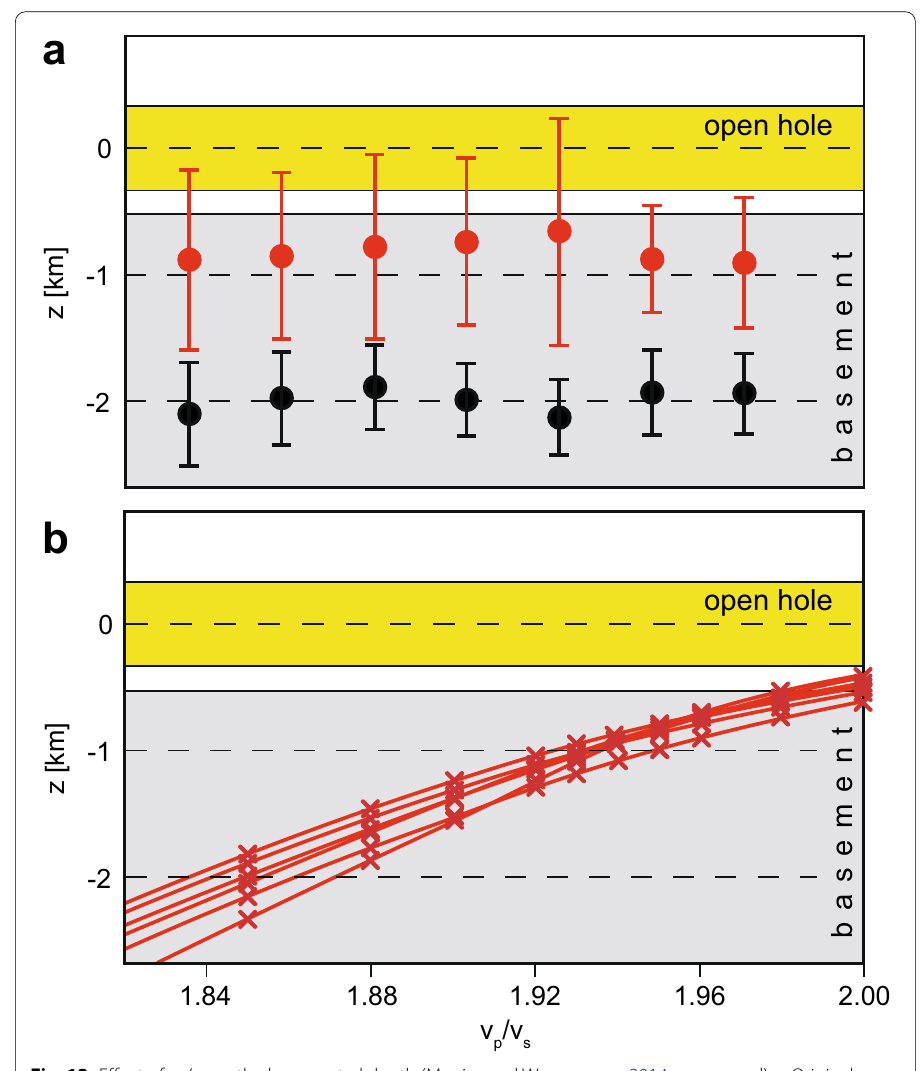
Fig. 13 Effect of v p /v s on the hypocentral depth (Megies and Wassermann 2014, rearranged). a Original hypocenter depths of seven events at Unterhaching based on a v p /v s ratio of 1.65 (black) and hypocenter depths based on a half-space model (red) with a ratio of 1.94 that was derived from rms residual minimization. b Individual variation of hypocenter depths of the seven events shown for a half-space model. As the v p /v s ratio approaches 2, hypocenter depths move closer to the top of the crystalline basement. Reprinted from Geothermics, 52, Megies T, Wassermann J, Microseismicity observed at a non-pressure-stimulated geothermal power plant, 36–49, (2014), with permission from